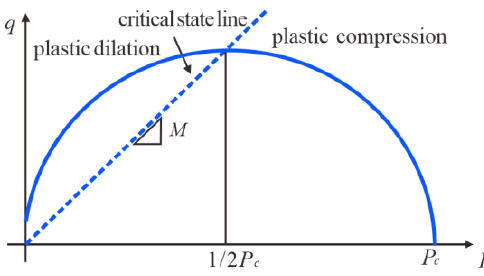
Figure 1. Yield surfaces in the MCC model.